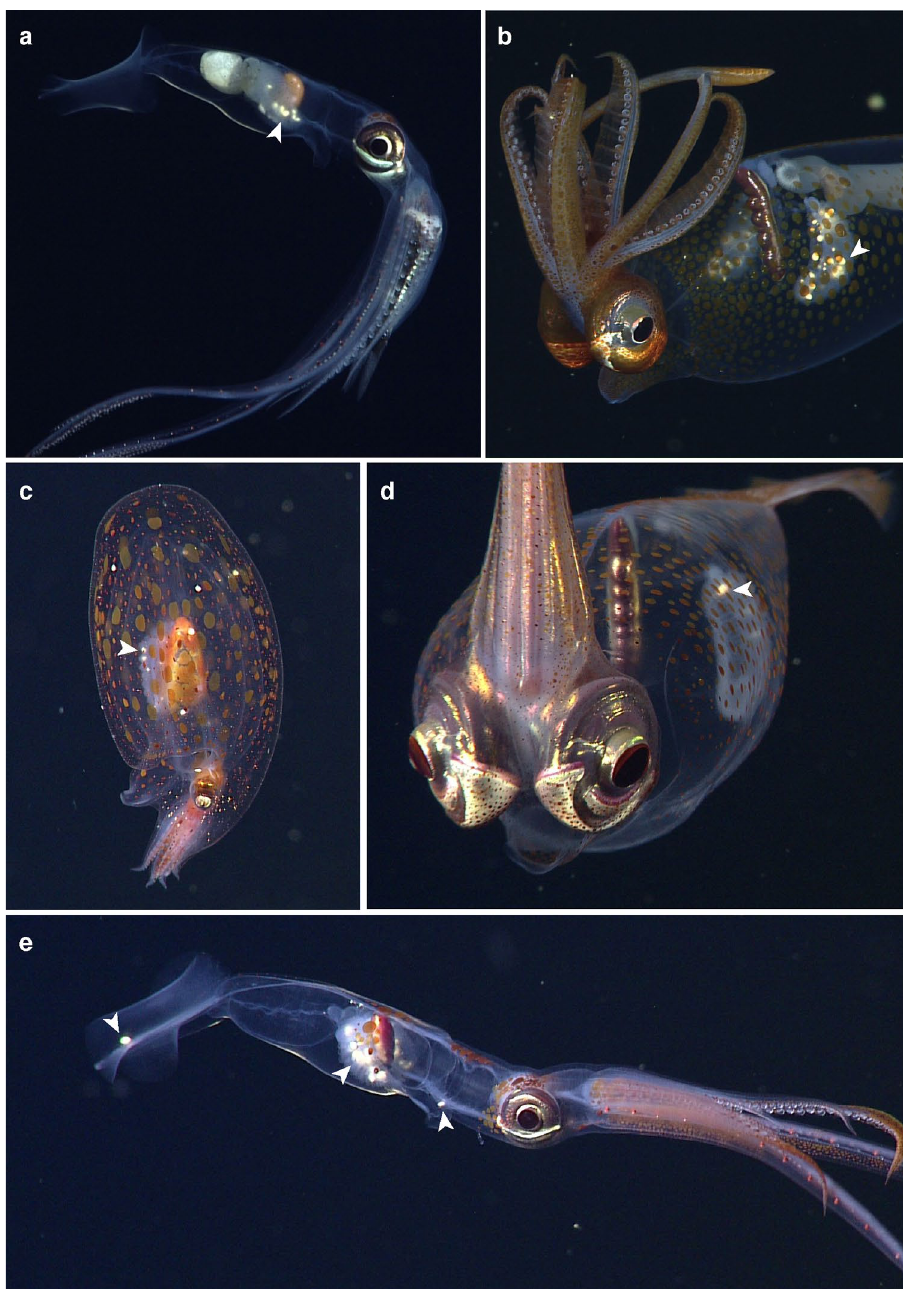
Figure 4. In situ observations of Hochbergia cf. moroteuthensis on gills of midwater cephalopods (white arrows). ( a ) Chiroteuthis calyx Young, 1972, here seen feeding on a myctophid fish. ( b ) Galiteuthis phyllura Berry, 1911. ( c ) Japetella diaphana Hoyle, 1885. ( d ) Taonius boreali s (Nesis, 1972). ( e ) Chiroteuthis calyx with unusual infections on the inside of its funnel (right) and upper midline of the fins